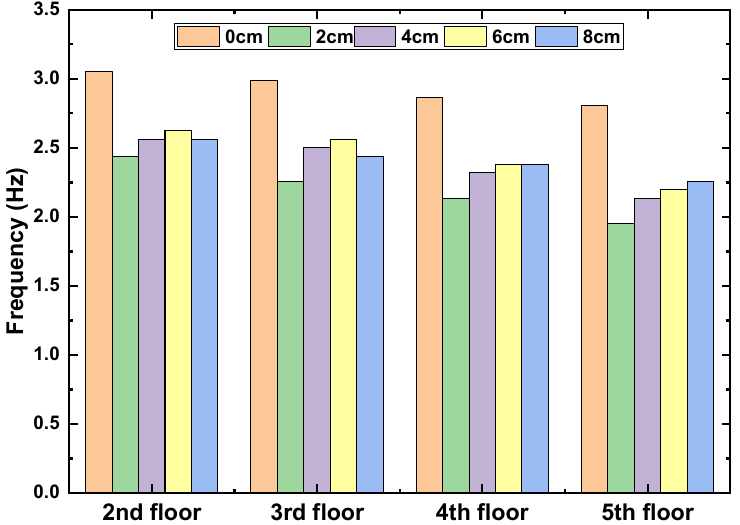
Figure 11. The first natural frequency of the structure when the water tank with a different water level placed on the different floor.